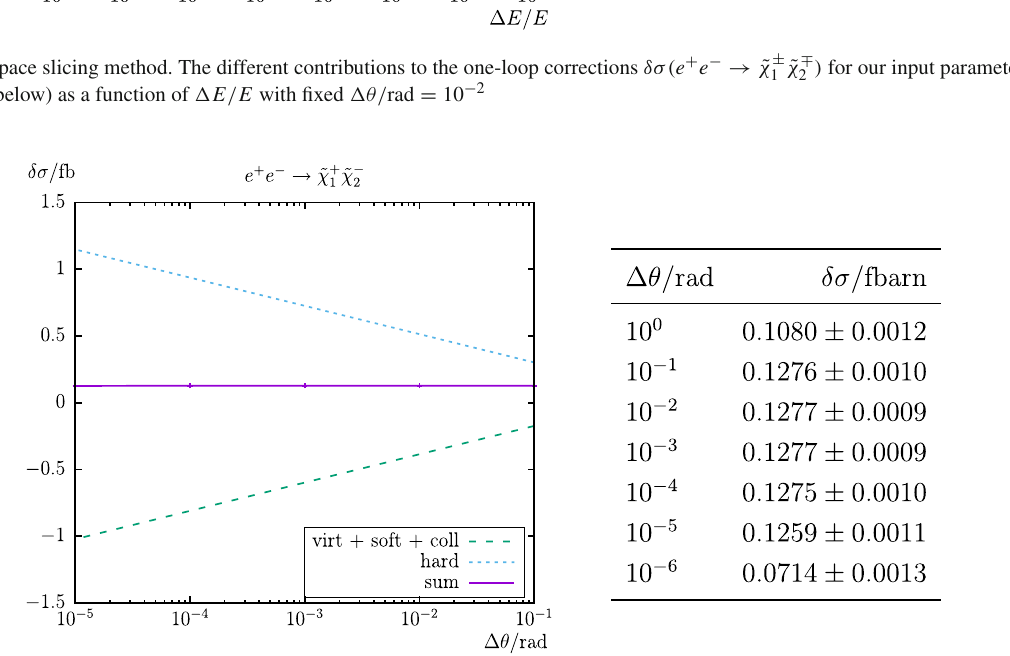
˜ χ ∓ ) for our input parameter scenario 1 2